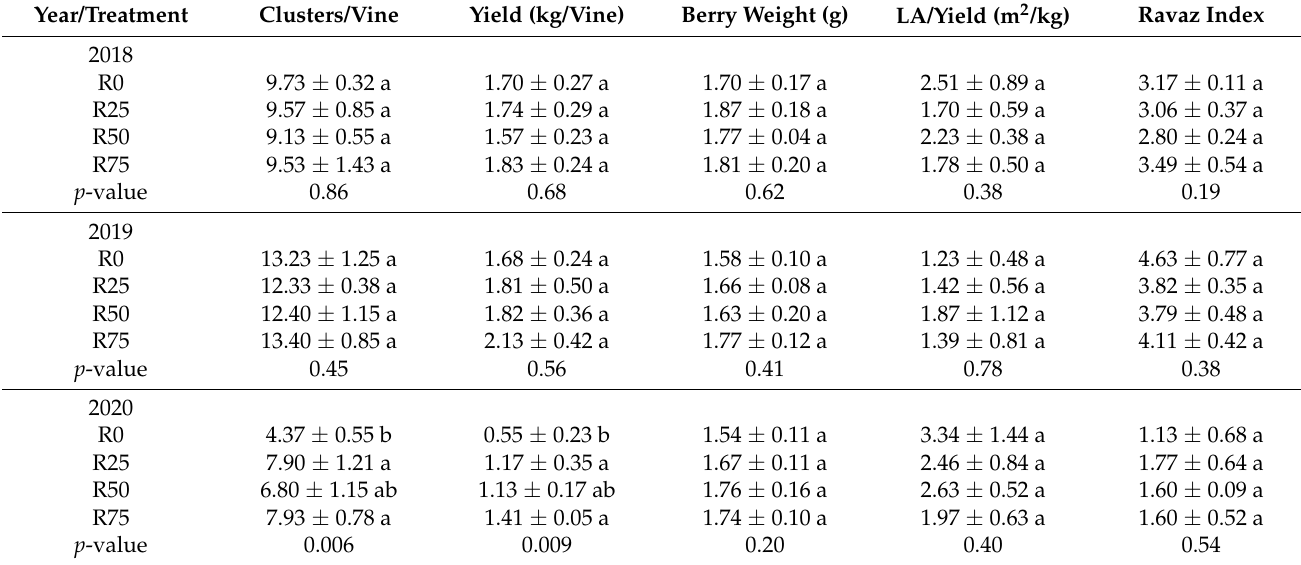
Table 2. Number of clusters per vine, yield, berry weight leaf area to yield ratio, and Ravaz Index of rainfed and irrigated vines during each season. Values are represented as mean ± standard deviation. In each column, values with different letters show a statistical significance at p < 0.05 by Tukey HSD